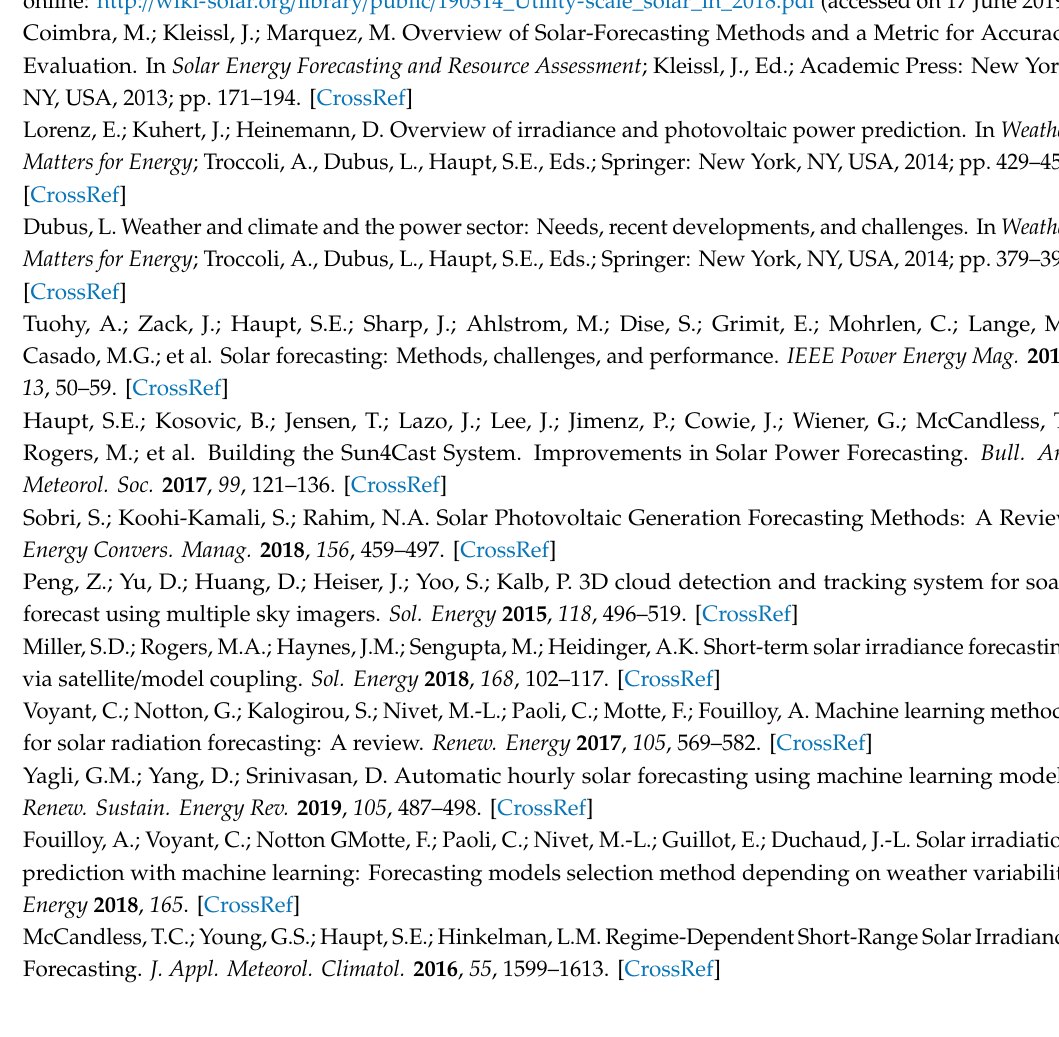
Figure A5. The 10 UTC generation time RMSE results on the test dataset for the CubistOpt method, the clearness index persistence and the DICast forecasts, which show that the CubistOpt (purple line) method has the lowest error over all time periods.